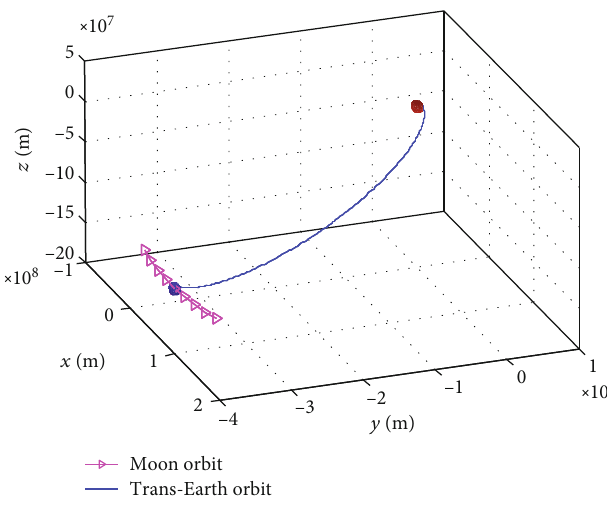
Figure 7: Three-dimensional demonstration of ETO in cislunar space. Table 4: Aerocapture parameters for the PM.